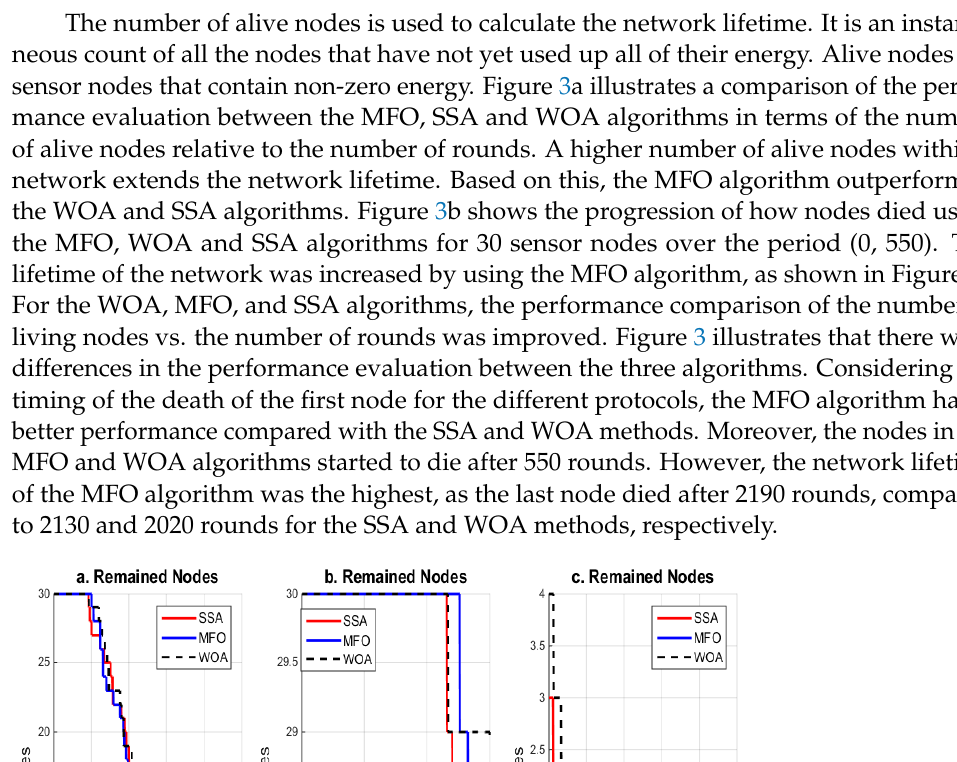
Figure 4. Variation in throughput in MFO, SSA and WOA. 4.1.4. Residual Energy To ensure the network’s long-term viability, limited resources must be used wisely. When it comes to wireless networks, energy conservation is the most important factor in